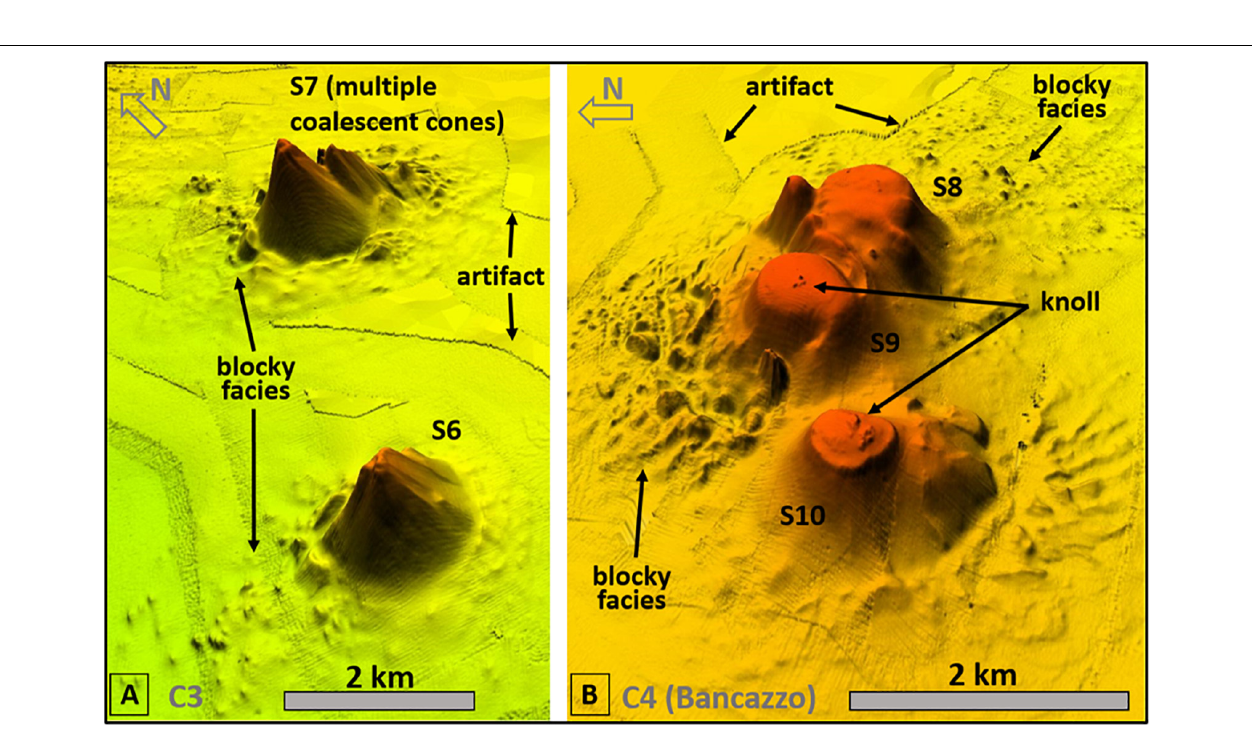
Frontiers in Earth Science |